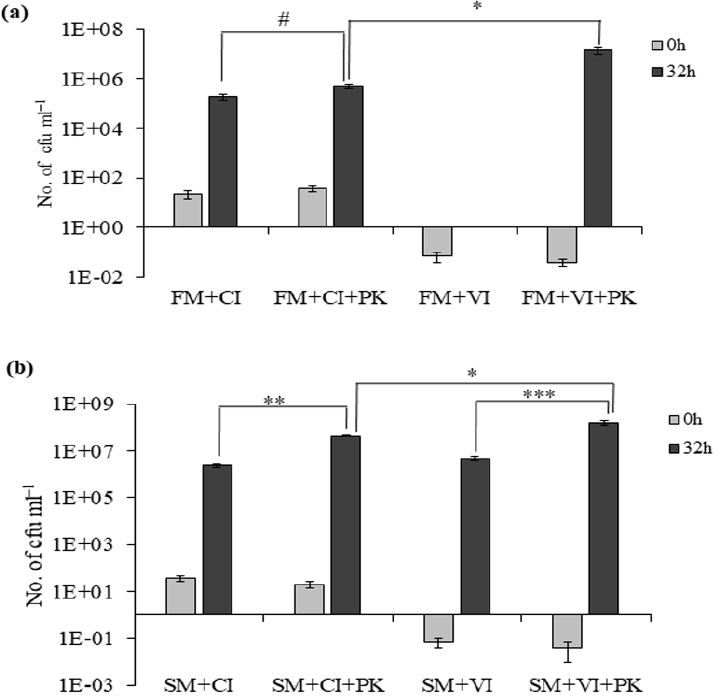
Figure 2. Effect of proteinase K on VBNC and culturable cells in ASW and spent ASW media. ( a ) Growth of culturable cells (CI) and recovery of VBNC cells (VI) in ASW media (FM) without or with 100 μ g mL − 1 of proteinase K (PK); cell count was determined at 0 h and 32 h. # represents non-significant difference in growth of CI between FM and PK-supplemented FM. Asterisk ( ∗ ) represents statistically significant difference between the growth of CI and VI in FM+PK ( p < 0.05). ( b ) Growth of CI cells and recovery of VI cells in SM (spent ASW media) and SM+PK. Each bar represents the mean ± SE of three independent experiments. Asterisk ( ∗∗ ) represents statistically significant difference in growth of CI between SM and SM+PK. ( p < 0.001).Asterisk ( ∗∗∗ ) represents statistically significant difference in growth of VI between SM and SM+PK. ( p < 0.02). Asterisk ( ∗ ) represents statistically significant difference in growth between CI and VI in SM+PK ( p < 0.05).